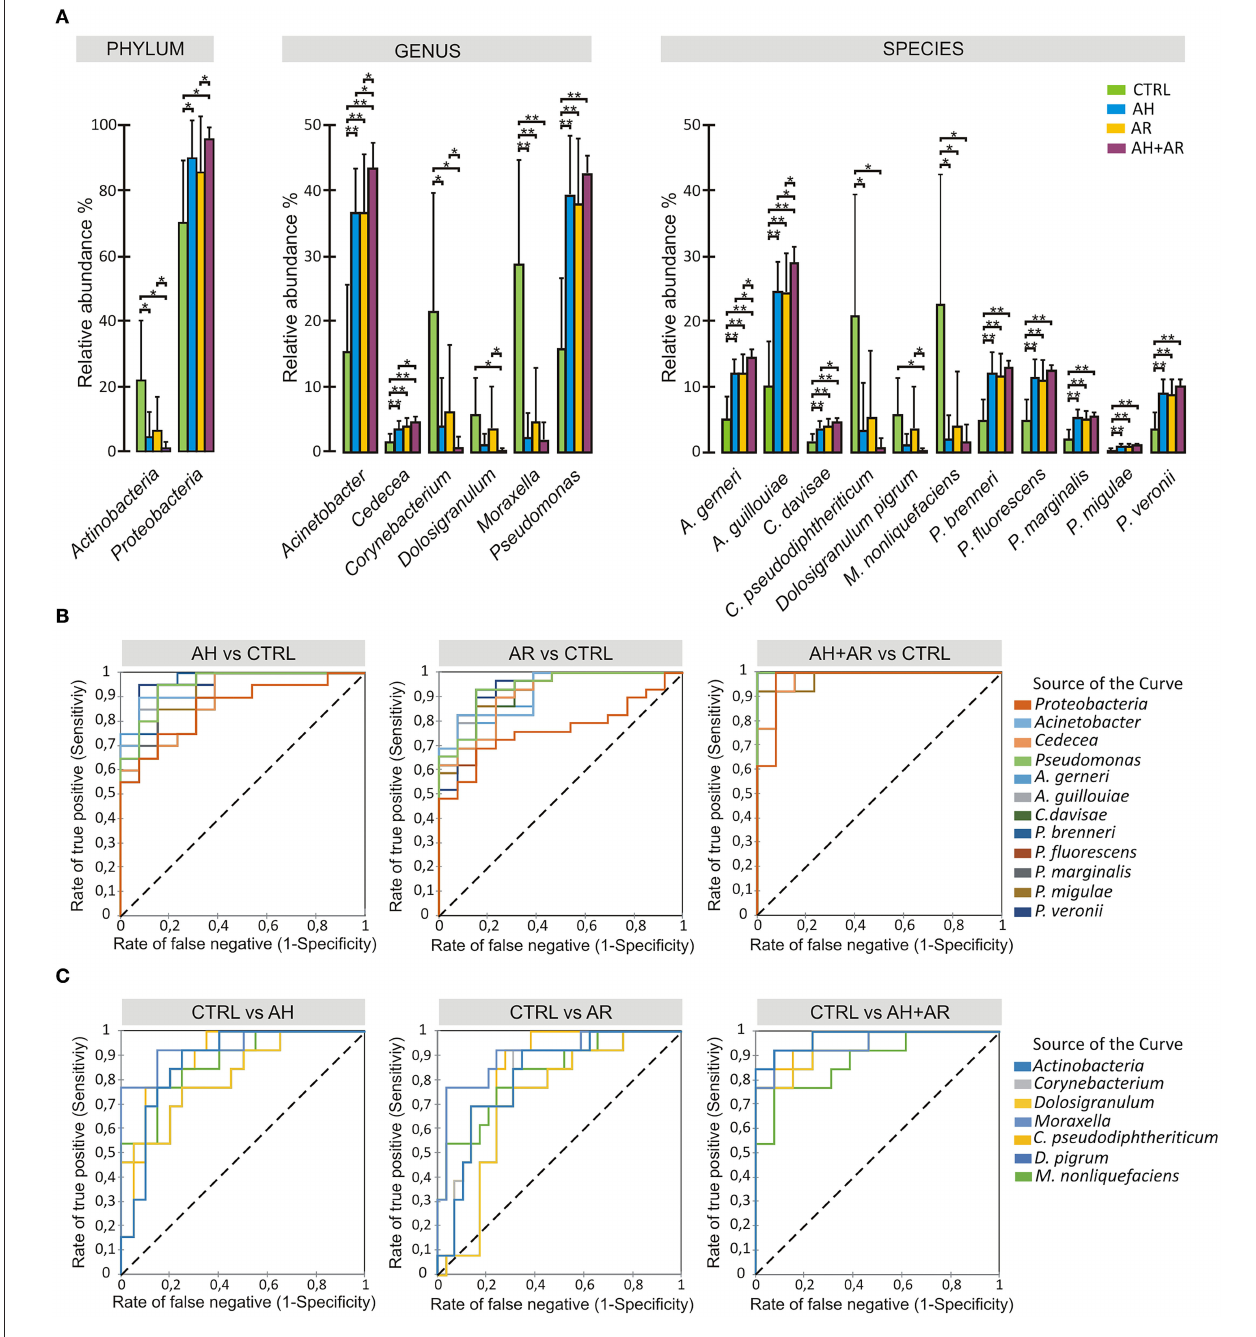
FIGURE 3 | Differential abundance analysis and diagnostic power of most abundant taxa. (A) Color-coded barplots showing differential abundance analysis at phylum, genus and species levels performed by Kruskal-Wallis test followed by Games-Howell post hoc tests with Benjamini-Hochberg FDR correction to account for multiple comparisons. Only taxa showing significant differences among groups and for which a mean relative abundance ≥ 1% was determined in at least one group, are shown in plots. Values are expressed as mean ± SD. (B) ROC curve plots for taxa differentially abundant in diseased groups and in (C) control subjects. The areas under the ROC curves represent the specificity and sensitivity of the selected taxa able to discriminate AH, AR and AH + AR phenotypes from the control group. Dotted line represents the AUC = 0.5 (random classifier). * p ≤ 0.05; * p ≤ 0.001. presenting a number of degrees equal or > 50% of the a different degree in each disease. In order to identify highest number of connections presented by a single node in main taxa within microbial networks (Hubs), a degree based all approach was used by considering, as important, nodes